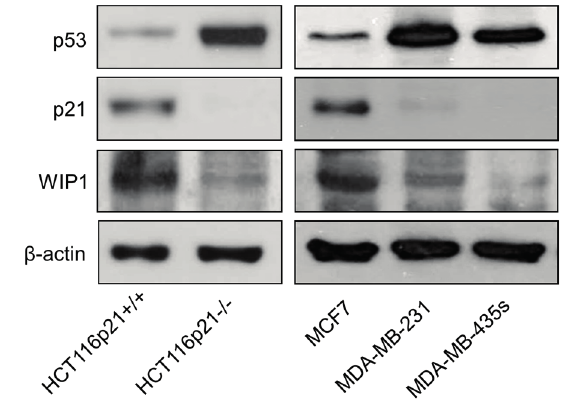
Figure 8. Immunoblot analysis of constitutive p53 (global), p21 and WIP1 protein levels in the indicated cell